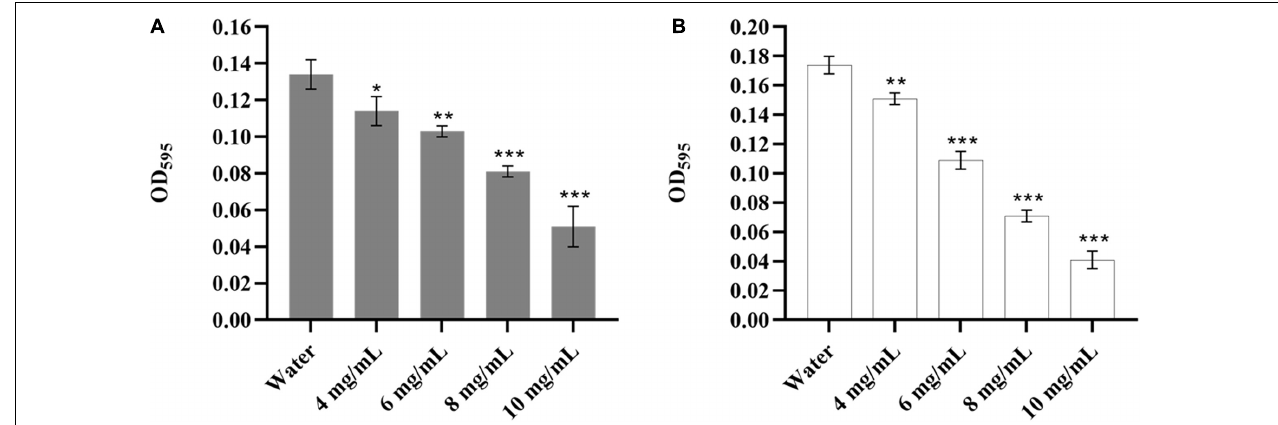
FIGURE 2 | The biofilm susceptibility of Y. enterocolitica affected by CA. (A) The effects of different concentrations of CA on established biofilm of Y. enterocolitica . (B) The effects of different concentrations of CA on biofilm formation of Y. enterocolitica